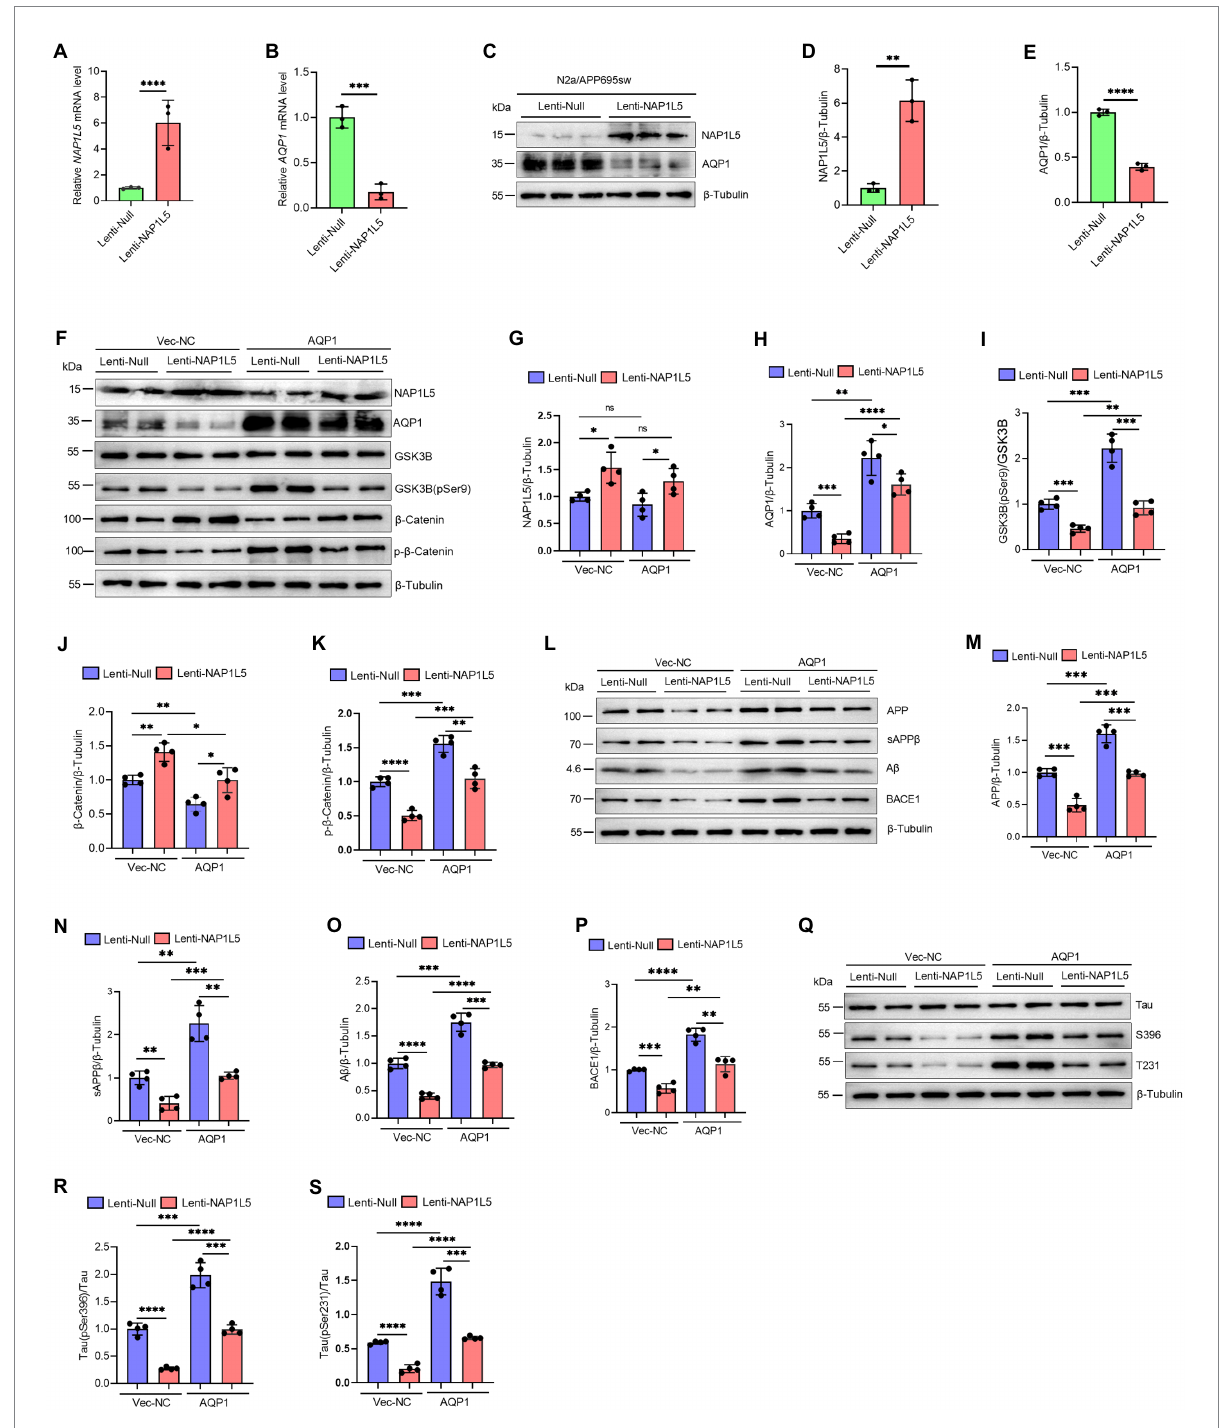
FIGURE 7 NAP1L5 alleviated AD-like pathological characteristics through AQP1-mediated mechanism in N2a-APP695sw cell. (A–E) N2a-APP695sw cells were stably infected Lenti-Null and Lenti-NAP1L5, NAP1L5 and AQP1 mRNAs were determined by RT-qPCR (A,B) ; the protein levels of NAP1L5 and AQP1 were measured by Western blot assays (C–E) . Data are present as means ± SD, n = 3. ∗∗ p < 0.01, ∗∗∗ p < 0.001 or ∗∗∗∗ p < 0.0001 by Student’s test. (F–S) , N2a-APP695sw cells, stably infected with Lenti-Null and Lenti-NAP1L5, were transfected with the control vector (Vec-NC) or AQP1 overexpressing vector (AQP1) for 48 h. Then, the proteins were extracted and the protein levels of related genes were detected by Western blot assays. (F–K) NAP1L5, AQP1, GSK3B, phosphorylation of GSK3B at serine 9 [GSK3B (pSer9)], β -Catenin and phosphorylation of β -Catenin were detected by Western blot assays and quantified. (L–P) APP metabolism-related protein levels were detected by Western blot assays and quantified. (Q–S) Tau protein and phosphorylation of Tau proteins were detected by Western blot assays and quantified. Data are present as means ± SD, n = 4. ∗ p < 0.05, ∗∗ p < 0.01, ∗∗∗ p < 0.001 or ∗∗∗∗ p < 0.0001. Student’s